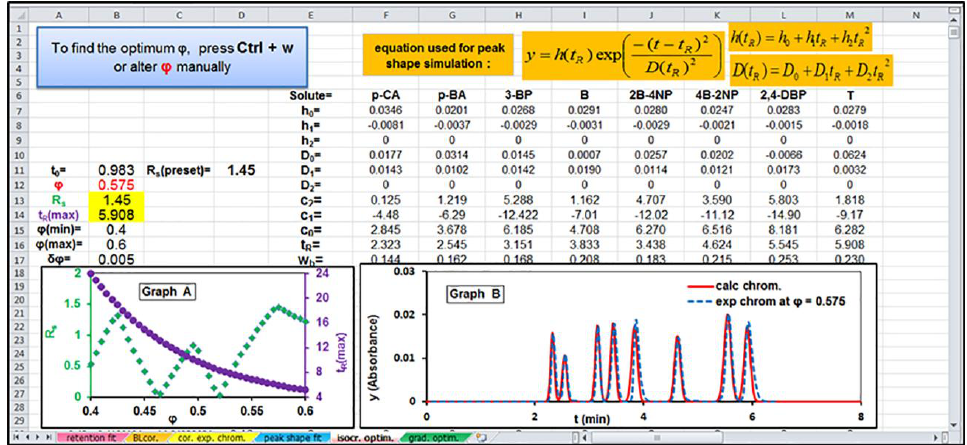
Figure 6. Screenshot of the MS Excel spreadsheet ‘isocr. optim.’ used for isocratic separation optimization of solutes in eluent pH 3 modified with MeOH. See the text for details.